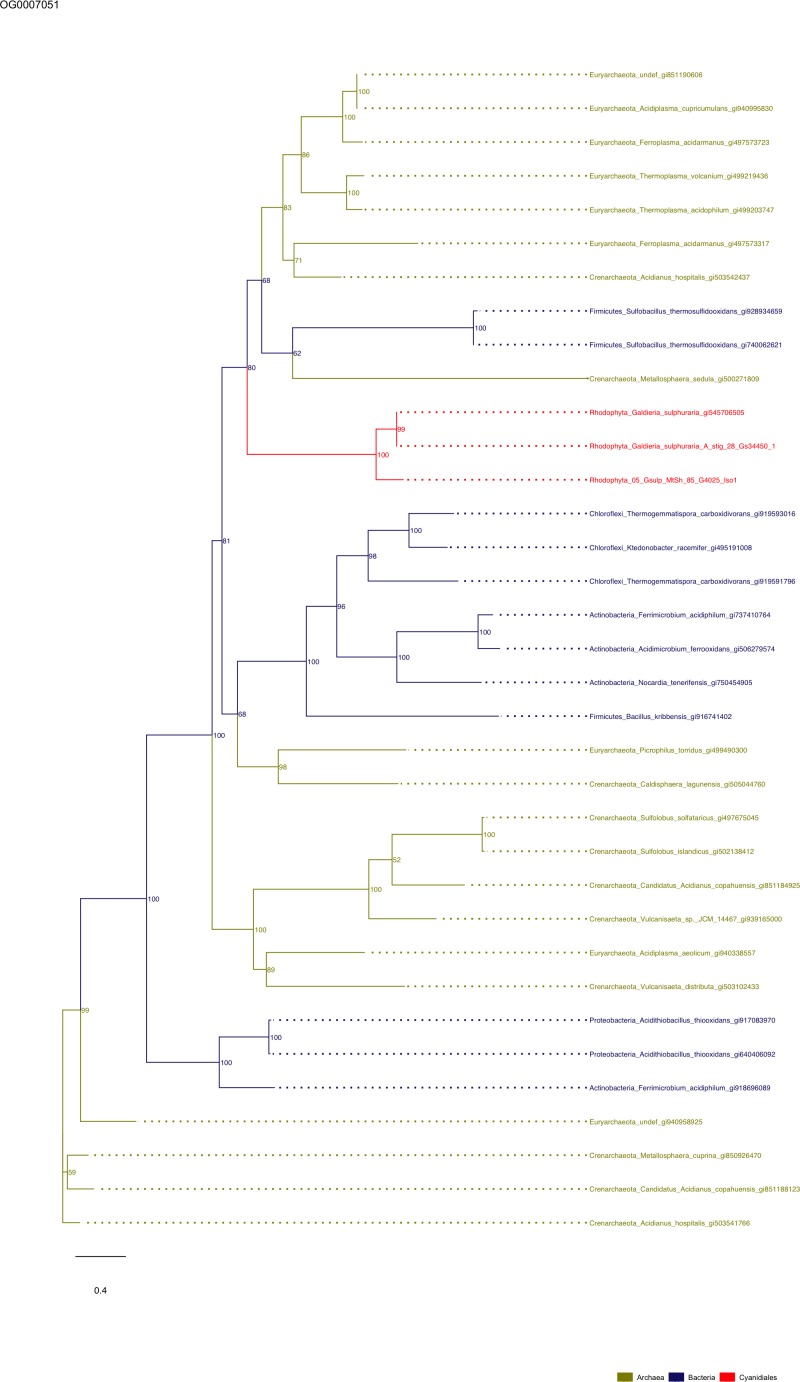
Sequence tree of orthogroup OG0007051.The tree is based on amino acid sequences. Archaea (yellow), Bacteria (blue), Cyanidiales (red), Eukaryotes including other red algae (green). Branches containing Cyanidiales sequences are highlited in red.